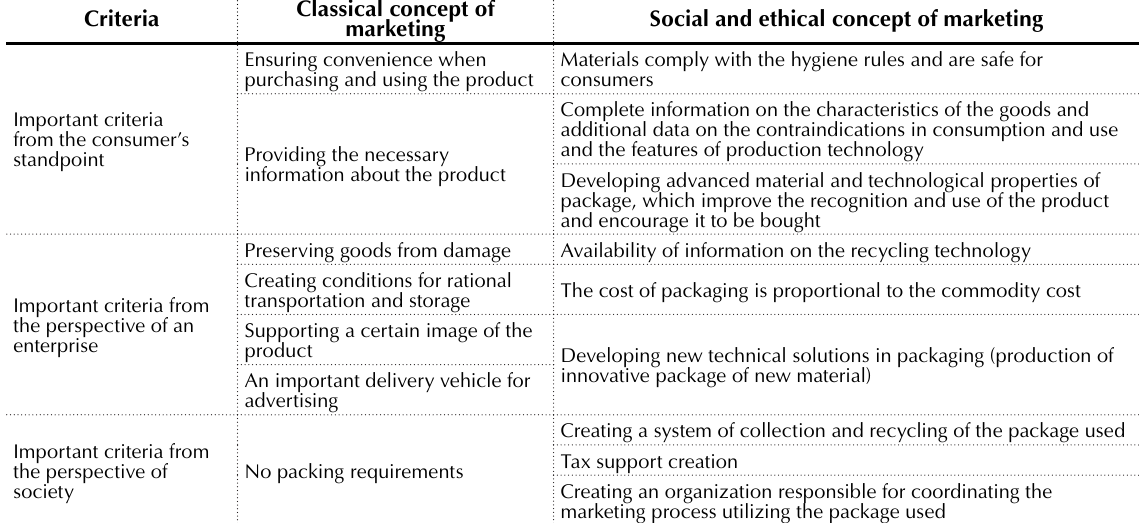
Table 1. Comparative characteristics of the packaging criteria in the classical and social and ethical marketing